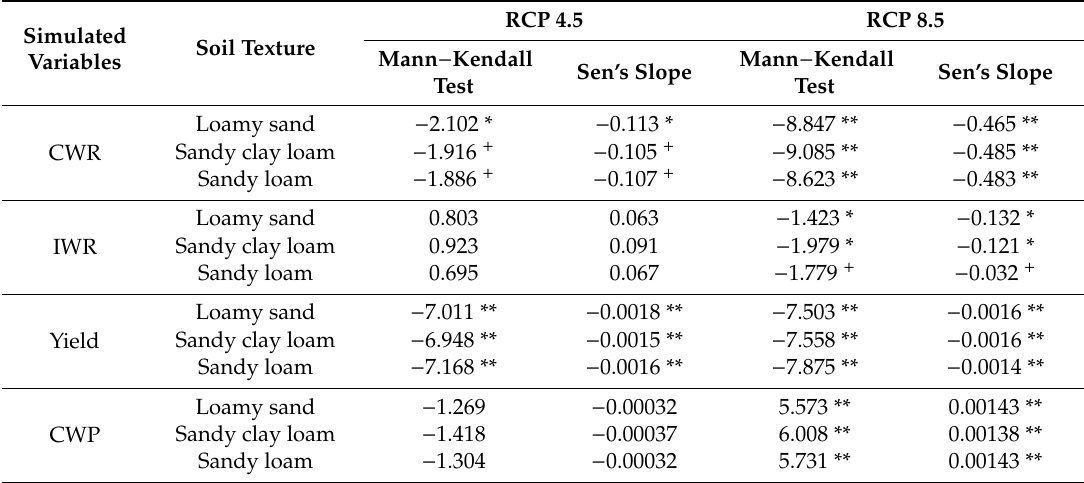
Table 7. Results of significance tests for the future simulations.